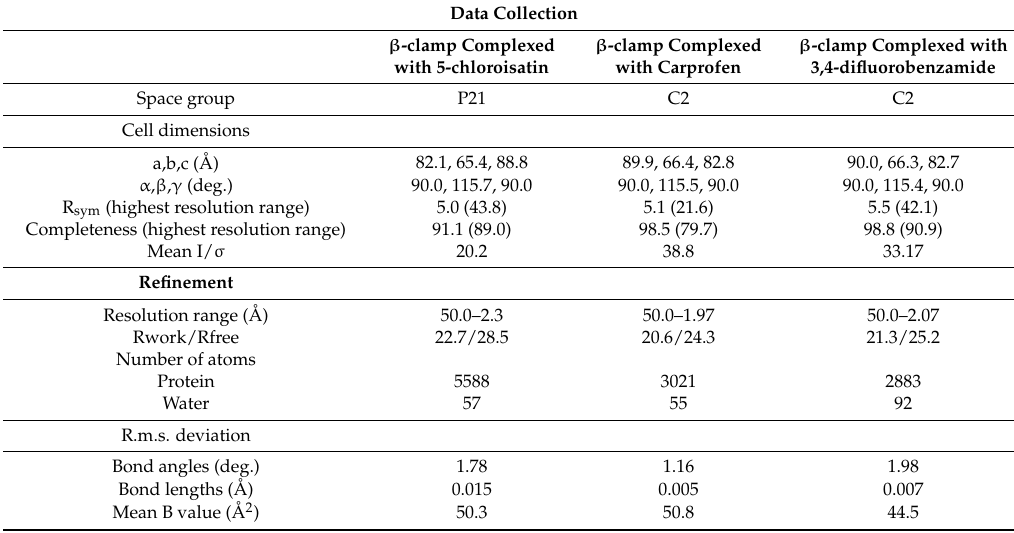
Table 1. Crystallographic data and refinement statistics for H. pylori β -clamp in complex with various